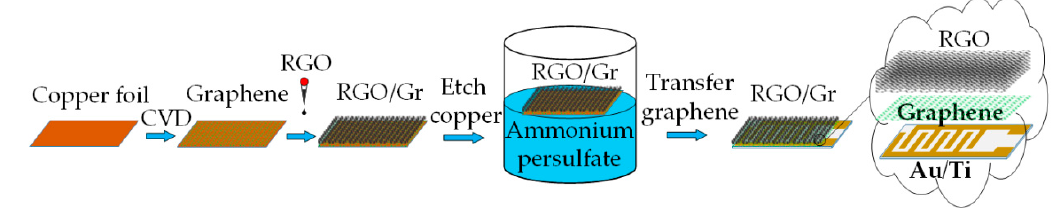
Figure 2. Fabrication process of the RGO-Gr hybrid gas sensors.